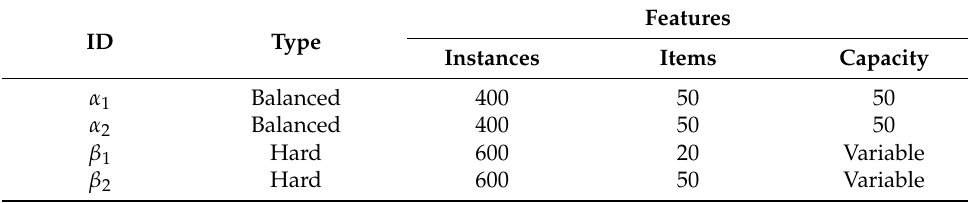
Table 1. Datasets used in this